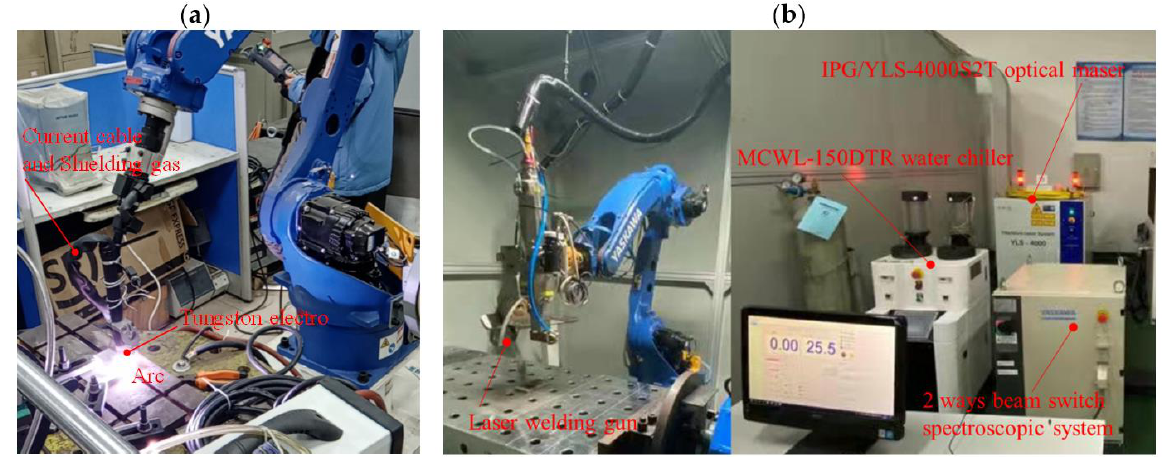
Figure 3. Welding process of Ti6Al4V titanium alloy: ( a ) TIG welding, ( b ) LBW. Table 2. Welding parameters for TIG welding and the dimensions of the weld seam.